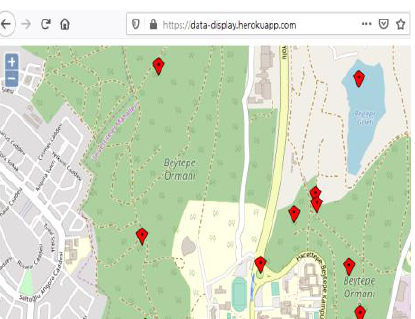
Figure 4. An exemplar output of the ‘online’ track – visualising collected data on the web